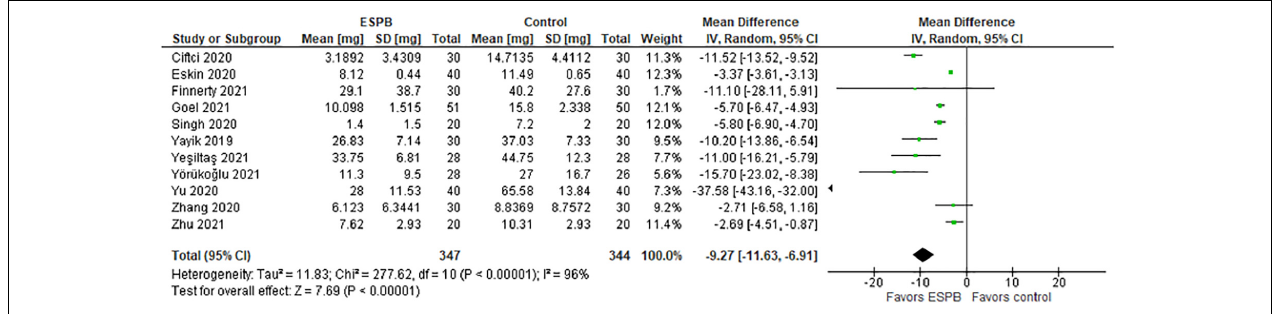
FIGURE 2 | Total opioid consumption within 24 h after surgery in mg of